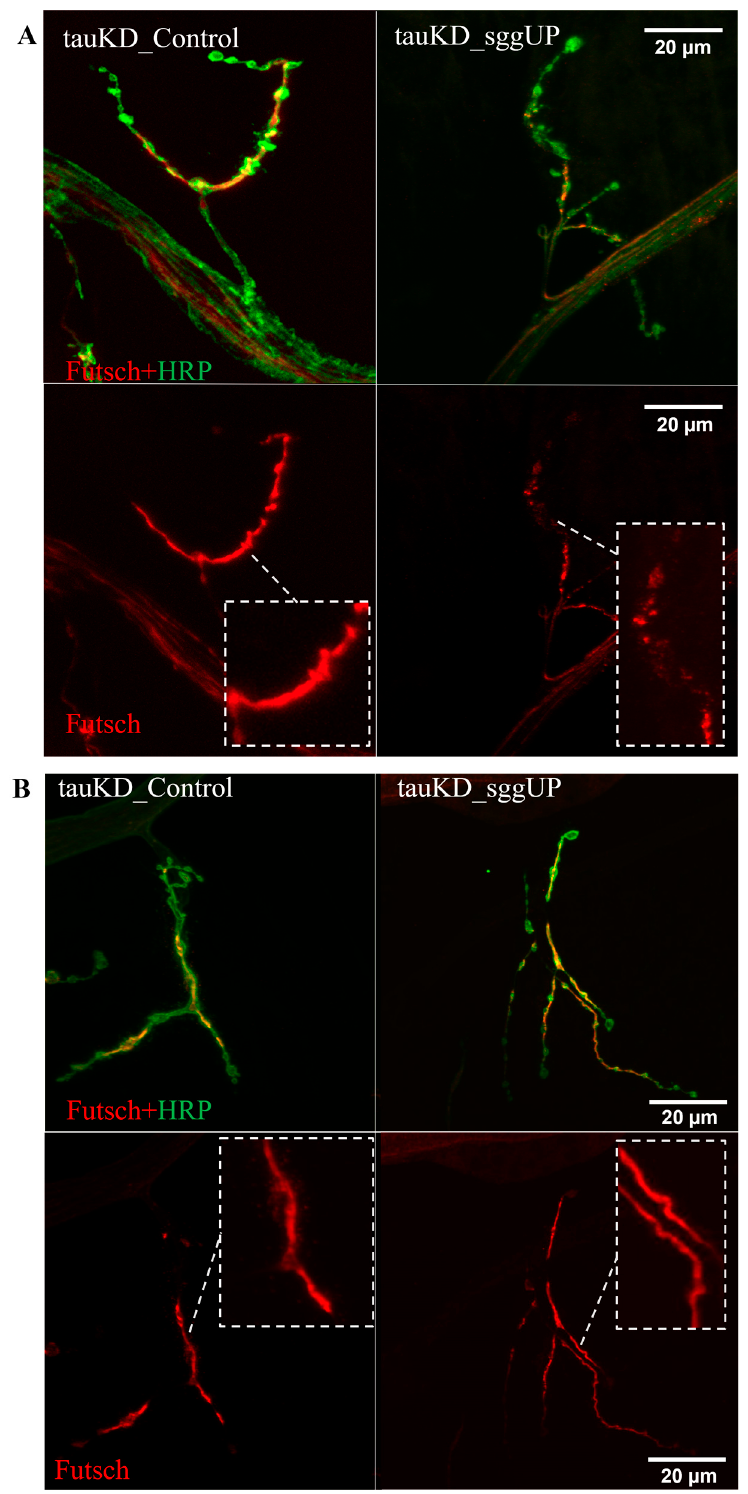
Figure 8. Activation of the transgene that decreases the expression of tau gene restores the distribution of Futsch protein impaired by the activation of the transgene that increases the expression of the RB transcript of the shaggy gene in females. ( A )—Immunostaining in males. ( B )—Immunostaining in females. Futsch is impaired by the shaggy overexpression in females but not in males. A detailed description of the genotypes is given in the Materials and Methods section.